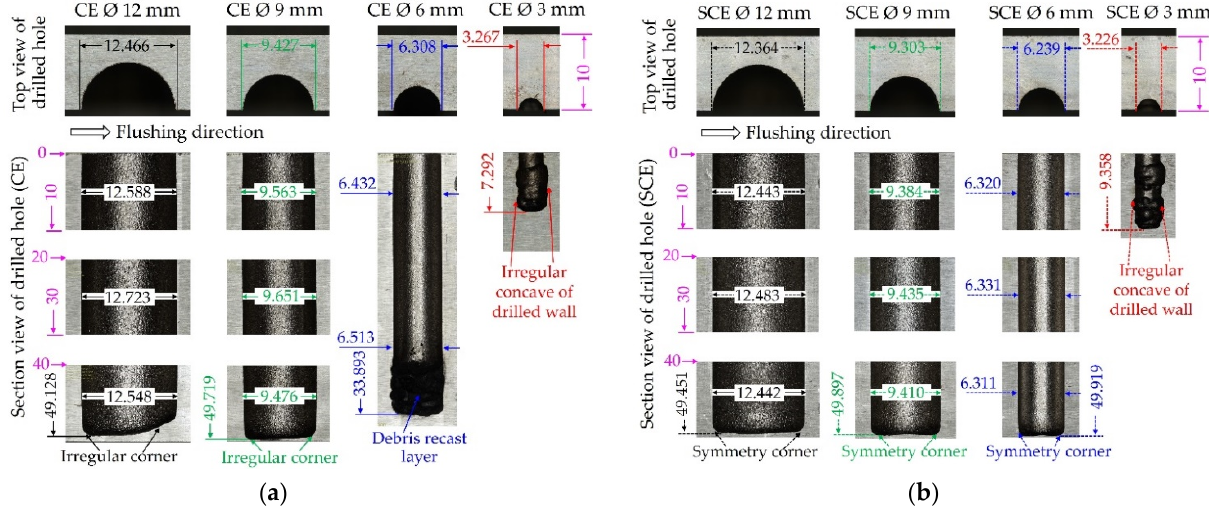
Figure 4. Photographs of each drilled hole and the actual depth of the drilled hole. ( a ) Drilled hole with conventional electrode (CE); ( b ) drilled hole with step cylindrical electrode (SCE).